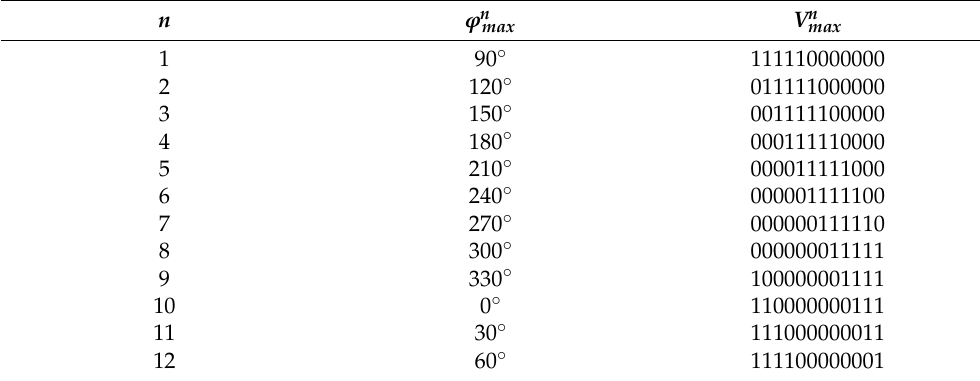
Table 1. The antenna’s main beam directions for different steering vectors applied to the Electronically Steerable Parasitic Array Radiator (ESPAR)